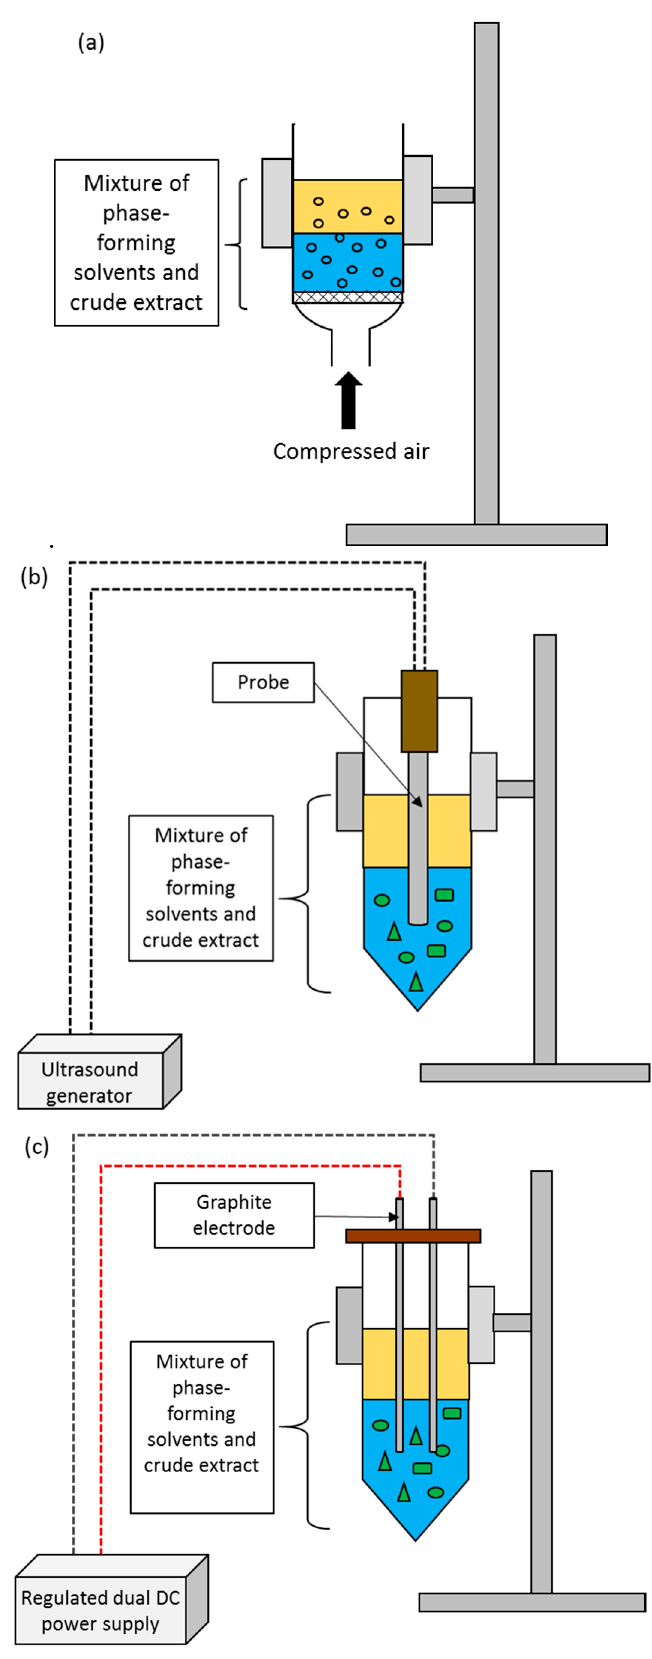
Figure 2. Schematic diagram of ( a ) bubble-assisted LBS, ( b ) ultrasound-assisted LBS, and ( c ) electricity-assisted LBS.